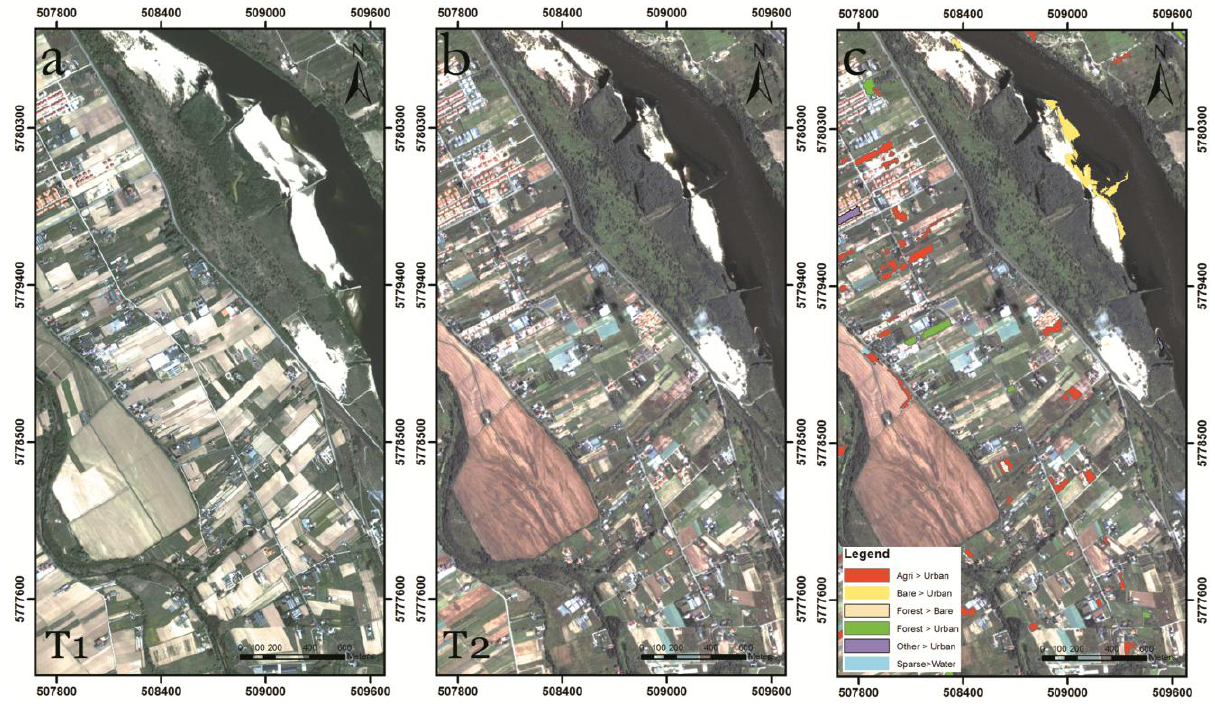
Figure 7. IKONOS image from 2002 ( a ) and IKONOS image from 2008 ( b ) with the change type layer overlaid on image T2 ( c ); subset of the Warsaw test area.